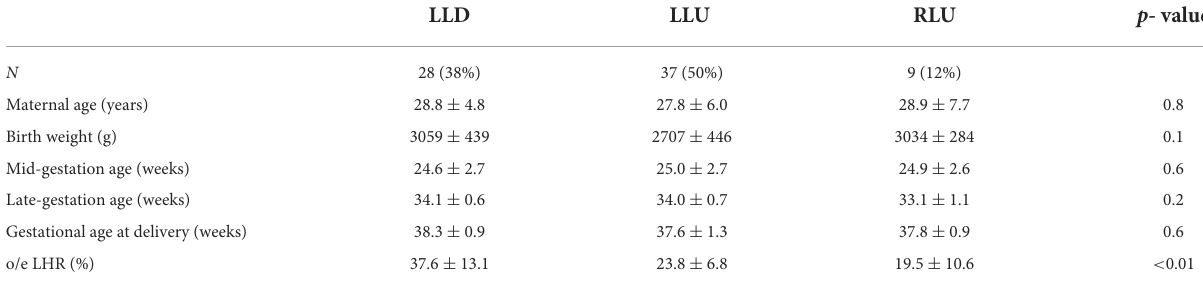
TABLE 1 Prenatal CDH cohort characteristics.